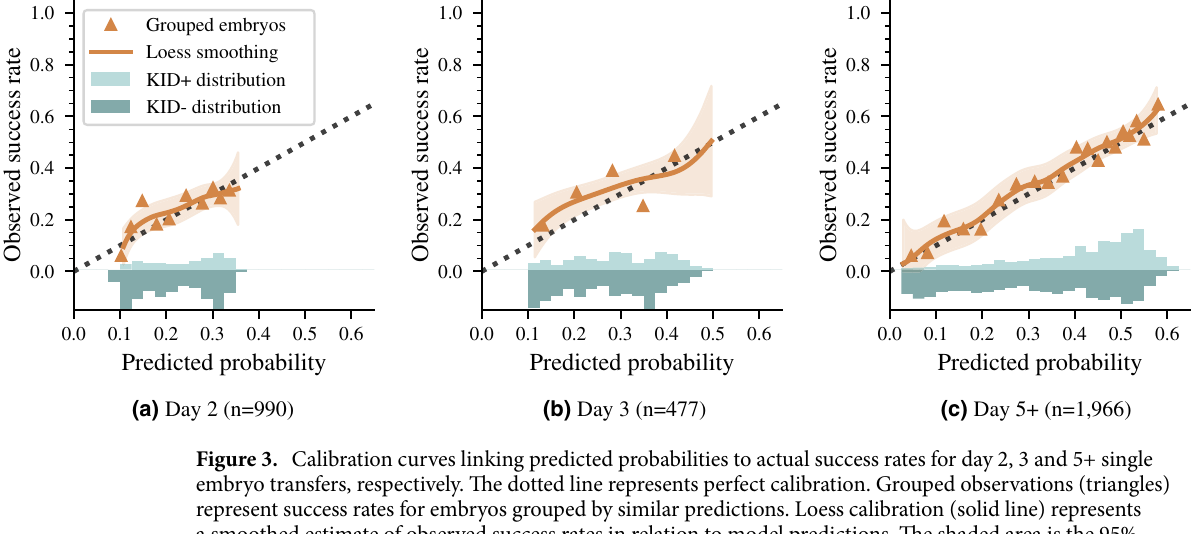
Figure 3. Calibration curves linking predicted probabilities to actual success rates for day 2, 3 and 5+ single embryo transfers, respectively. The dotted line represents perfect calibration. Grouped observations (triangles) represent success rates for embryos grouped by similar predictions. Loess calibration (solid line) represents a smoothed estimate of observed success rates in relation to model predictions. The shaded area is the 95% confidence interval. The relative distributions of scores for positive and negative pregnancy outcomes are shown at the bottom of the